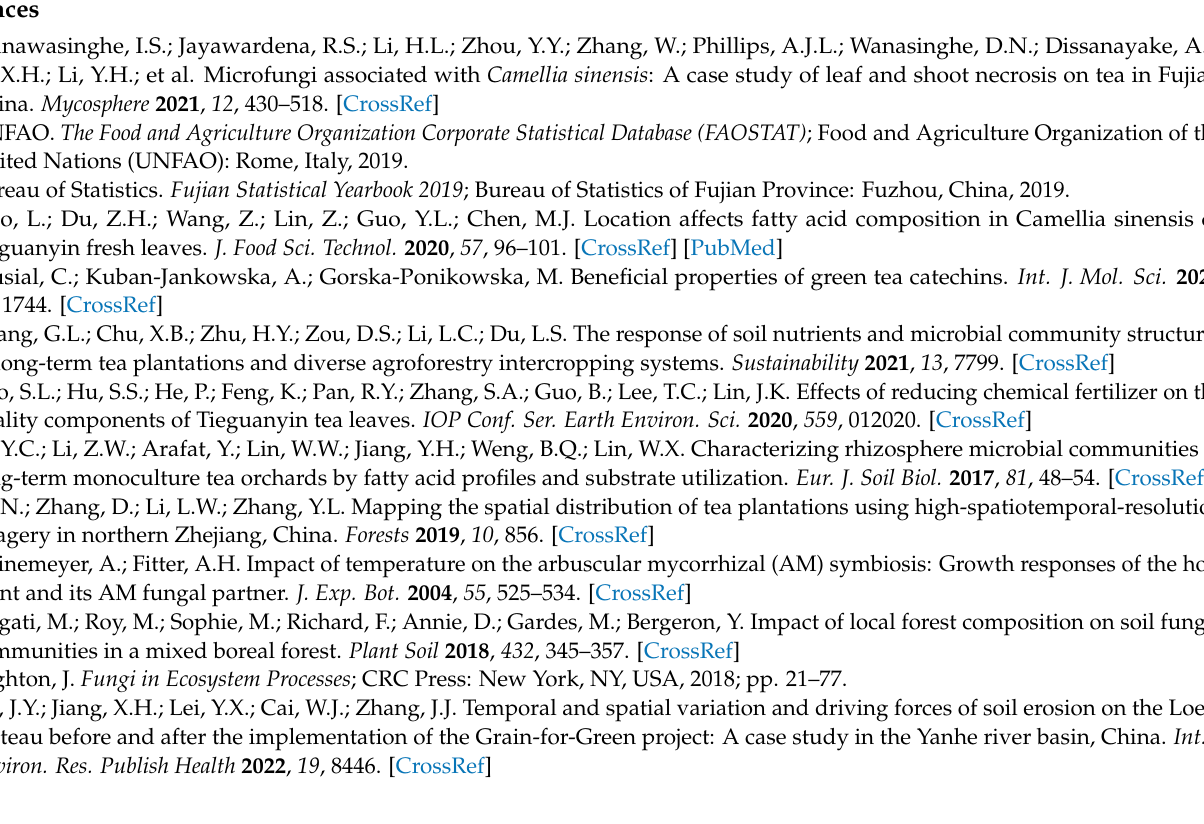
(Shannon index) at the OUT level; Table S1: Content of soil mineral elements in different forest types; Table S2: The correlation between OTUs of fungal functional guilds and soil chemical